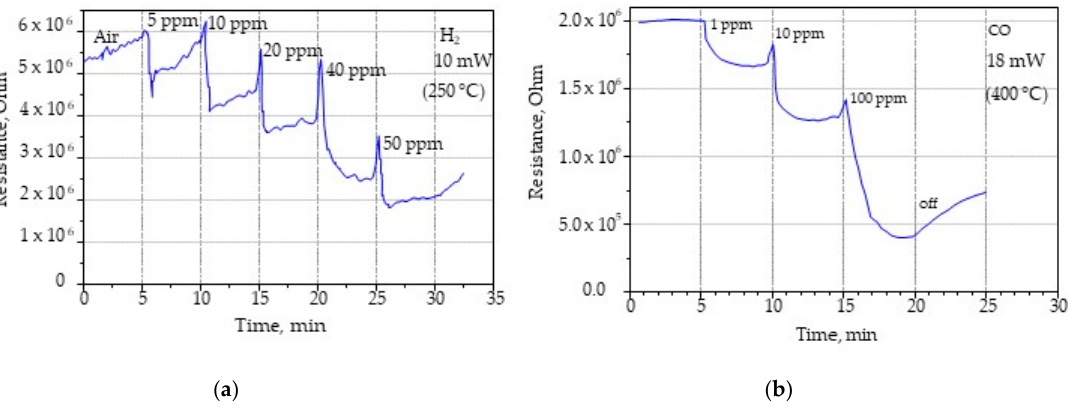
Figure 11. Responses of the gas sensor based on the thin membrane of nanoporous alumina sub- strate with a sensitive layer of Sn x Bi k Mo y O z : ( a ) for different concentrations of H 2 at heating power of 10 mW (250 °C); ( b ) for different concentrations of CO at heating power of 18 mW (400 °C).